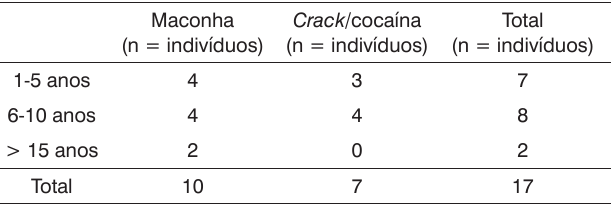
Tabela 3. Distribuição da amostra estudada, conforme tempo e tipo de droga consumida.